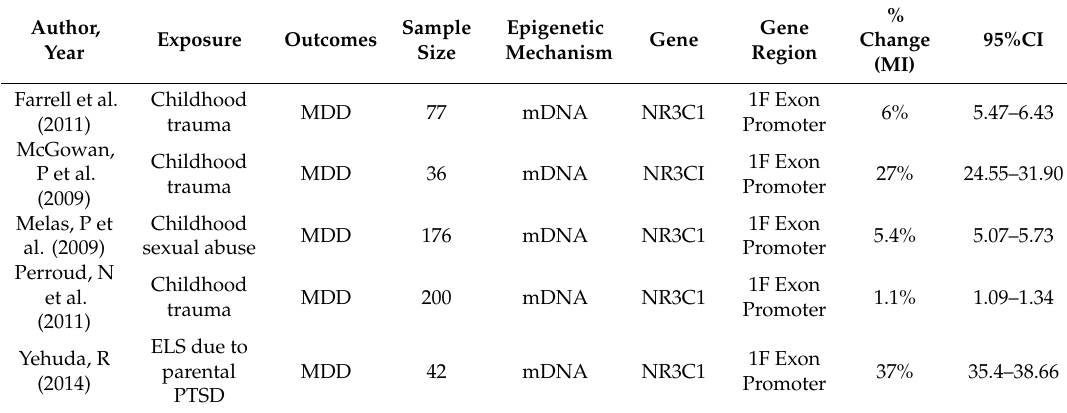
Table 1. mDNA of NR3C1 in Social Adversity and Major Depressive Disorder Correlation.